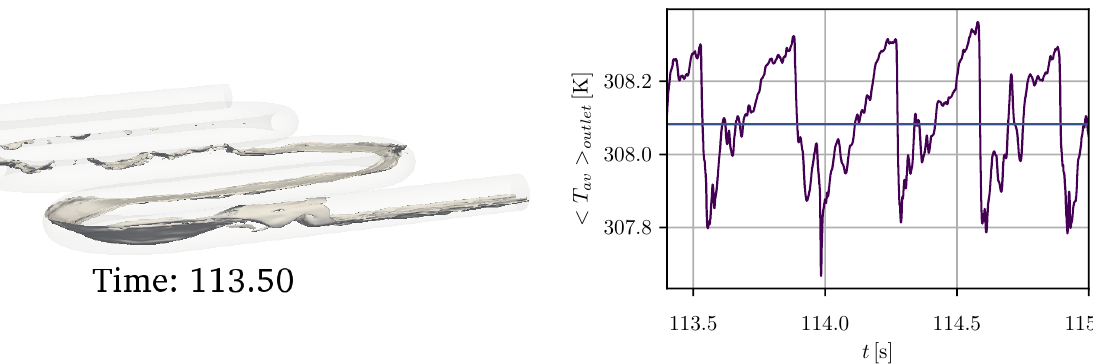
Figure 10. Visualization of the stratified wavy regime. ( Left ): instantaneous visualization of iso- contour α v = 0.5. ( Right ): time evolution of the phase-averaged mean temperature at the outlet: purple—instantaneous value; blue—time-averaged